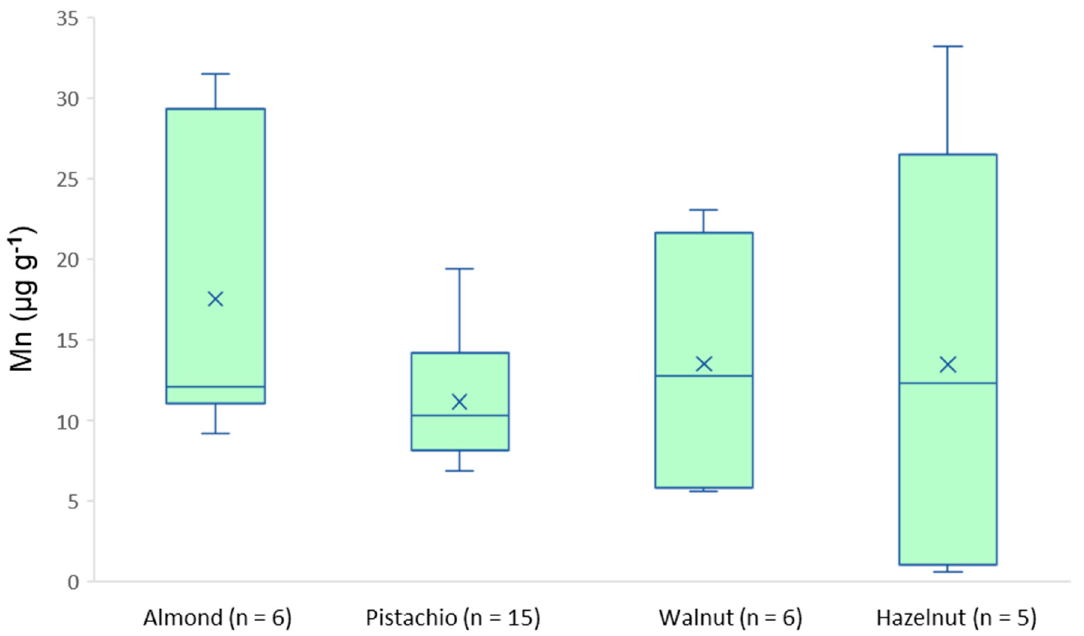
Figure 7. Box and Whisker plot for the concentrations of manganese among different nut species. The average concentrations of chromium in pistachios, walnuts and hazelnuts were very close (1.00, 1.78 and 1.03 μ g g − 1 , respectively) as shown in Figure 8. The average con- centration in almonds was higher (3.56 μ g g − 1 ). The ANOVA test exhibited a significant statistical difference in chromium concentration among all of the nut species with p = 0.005. However, there was no statistically significant difference between pistachios, wal- nuts and hazelnuts ( p = 0.22).